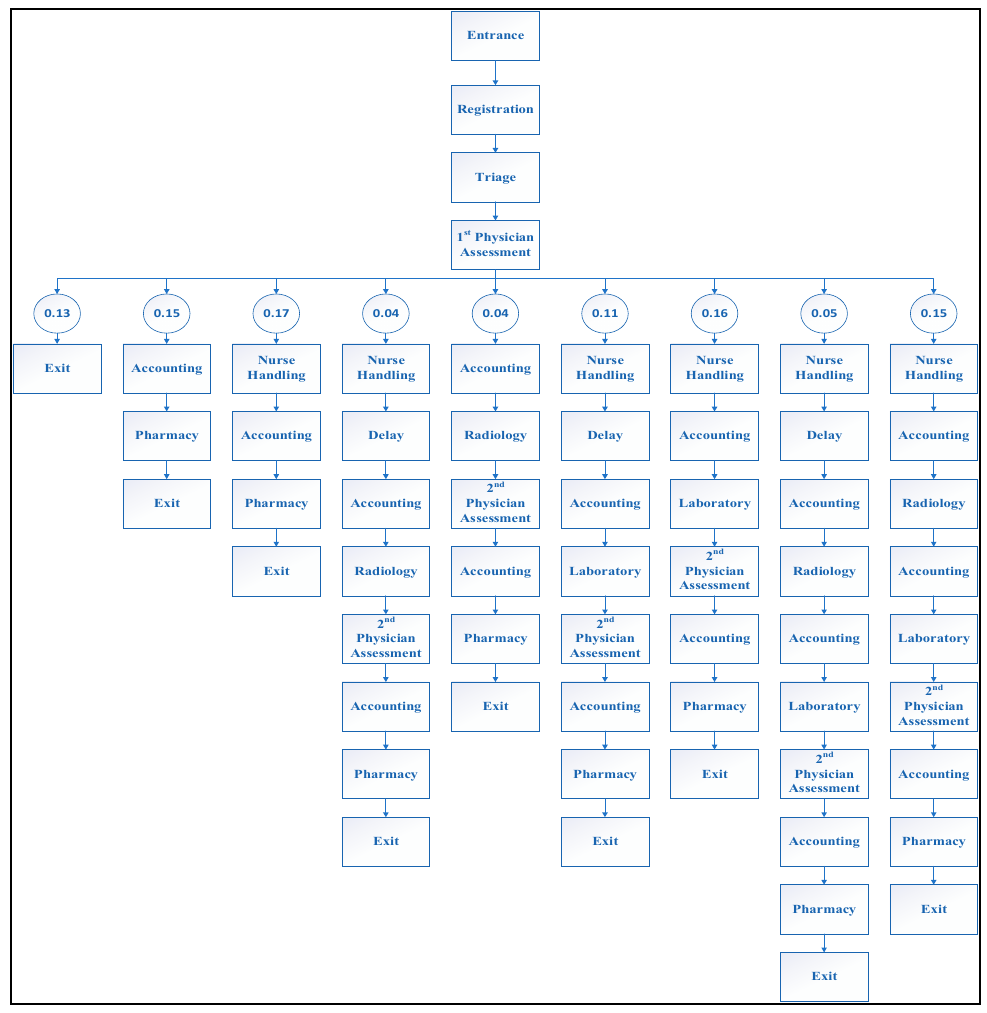
Figure 6. The paths of patients flow in PRPH’s emergency department with its associated probabil ‐ ities.